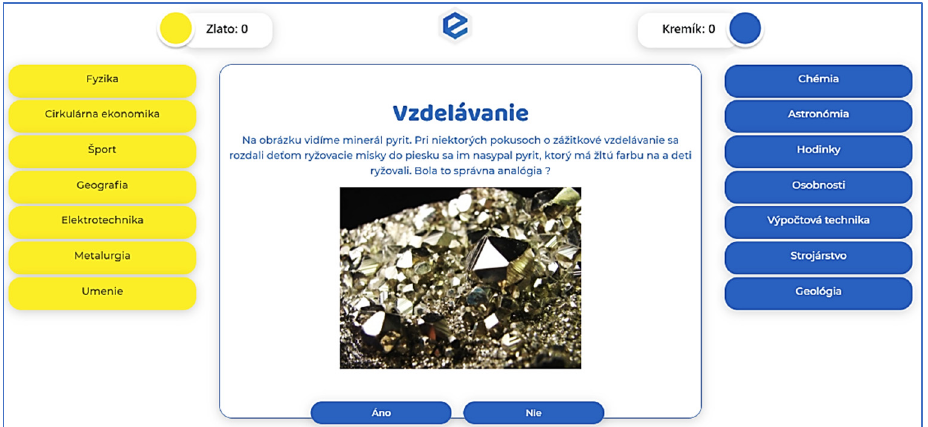
Figure 3. Innovative educational toolkit application [authors].